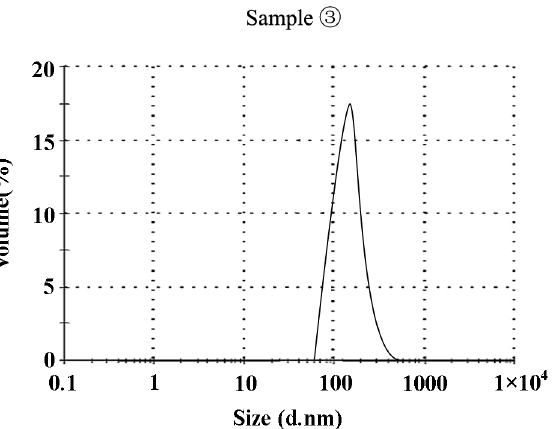
Figure 4. The particle size distribution of the system when the molar ratio of epoxy groups is E51:ED = 2:1.